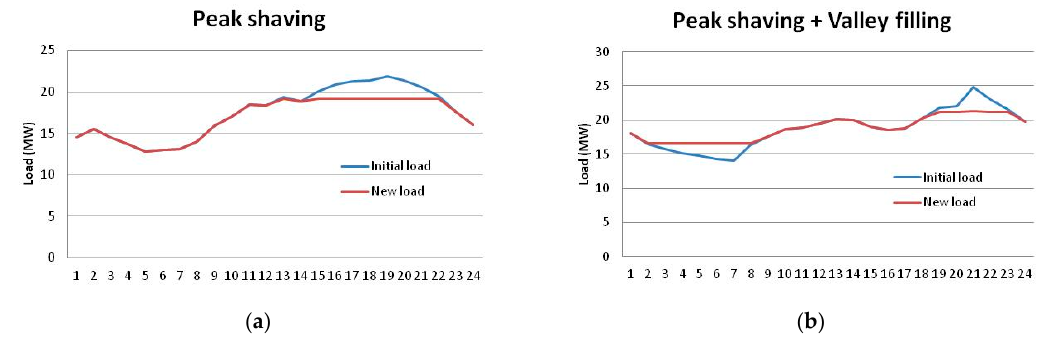
Figure 10. Variation of daily load curve considering P pump = 5 MW and P hydro = 3.5 MW: ( a ) Peak shaving operation of hybrid power station (day 4 of the year); ( b ) Peak shaving and valley filling operation of hybrid power station (day 206 of the year).